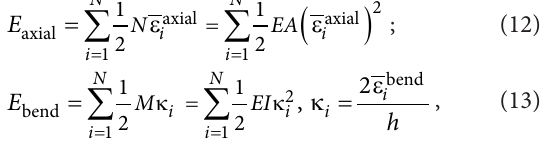
Figure 6. The displacement-based stressing state mode